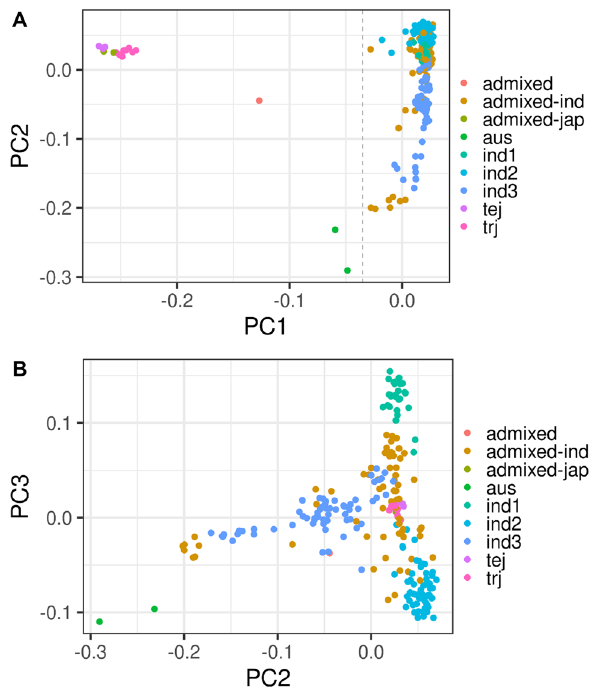
Figure 1. Population structure in PRAY Indica panel indicated by principal component analysis. Principal component analysis was performed in genotypic data in Plink, which separate different subpopulations identified by Wang, et al. 30 . PC1 vs PC2 ( A ) separates Indica accessions from Japonica; PC2 v PC3 ( B ) separates Indica